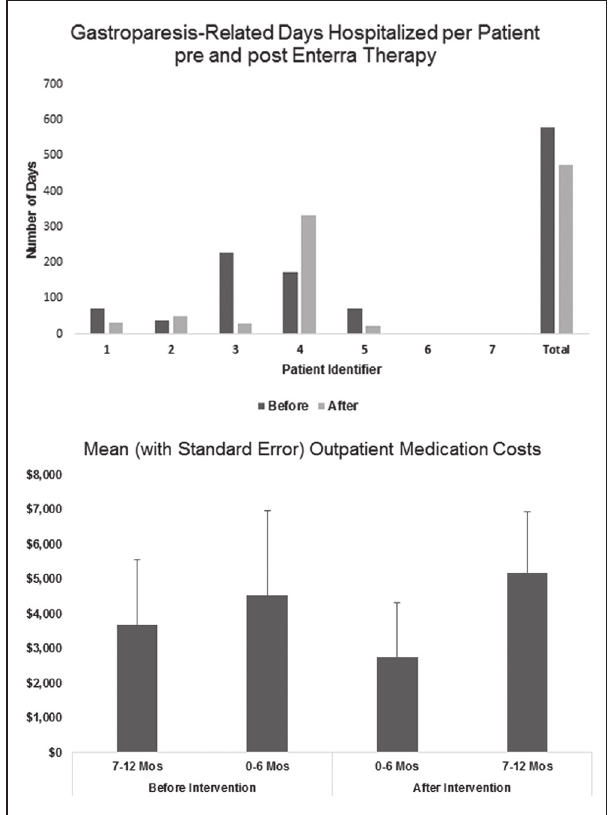
Figure 3) Health care-related costs, before and after Enterra (Medtronic, USA) implantation. Mos